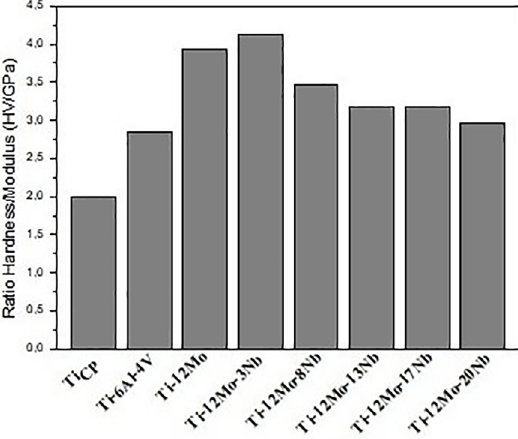
Figure 5. Hardness/modulus ratio for CP Ti, Ti-6Al-4V alloy and as–cast Ti-12Mo-xNb